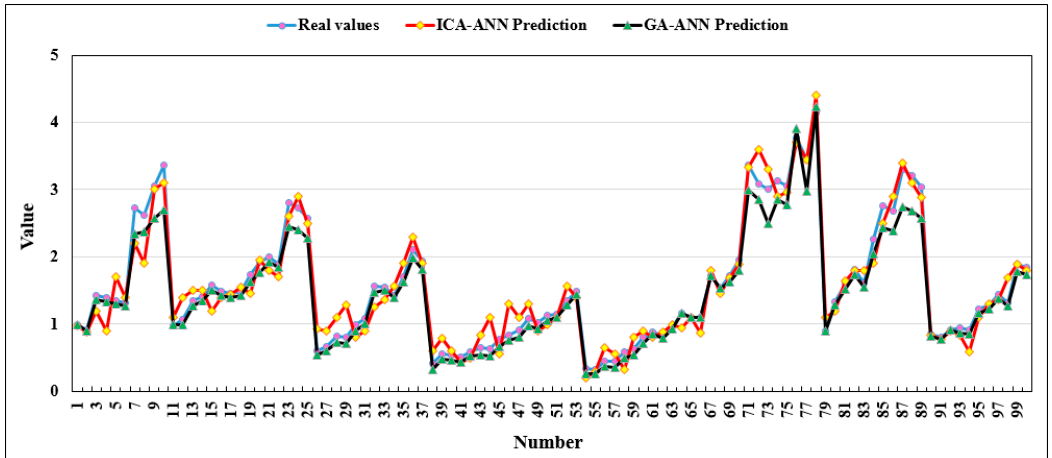
Figure 12. Comparison of real and predicted 100 number of data which was selected randomly in design of SF of the RWs.